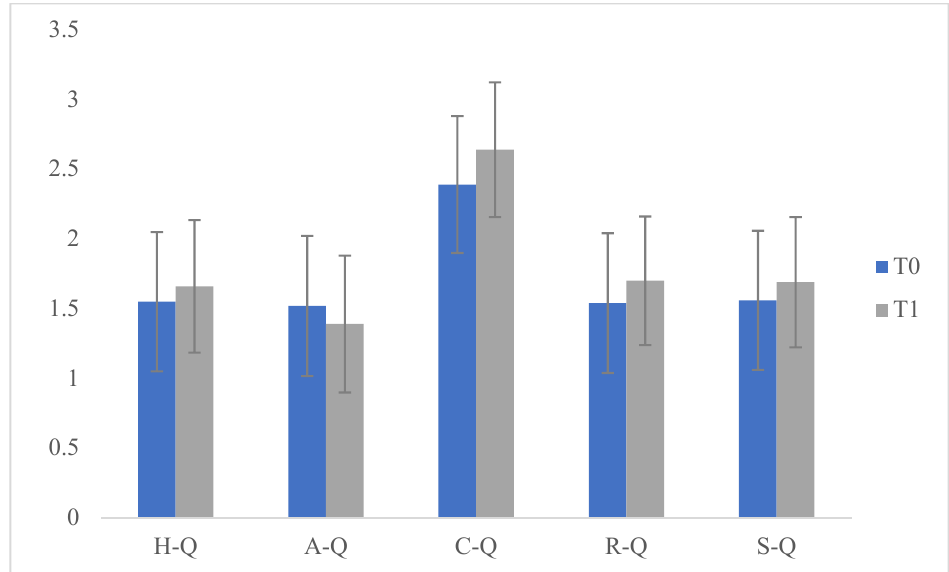
Figure 2. Comparisons of Questionnaire, T0 and T1. Additionally, we compared the scores obtained at T1 and T2 and significant differences